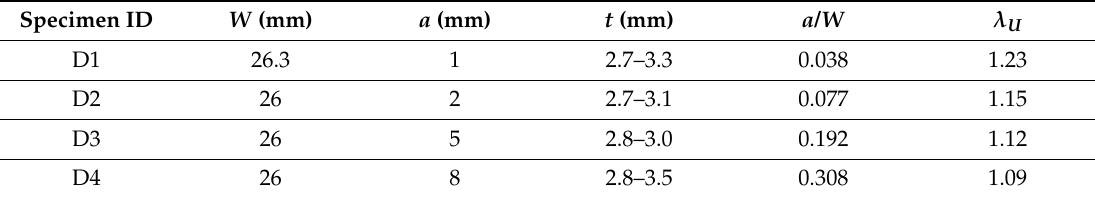
Table 4. Geometric characteristics of the edge-cracked plates with intrinsic defects. The rightmost column contains the ultimate remote stretch before failure.